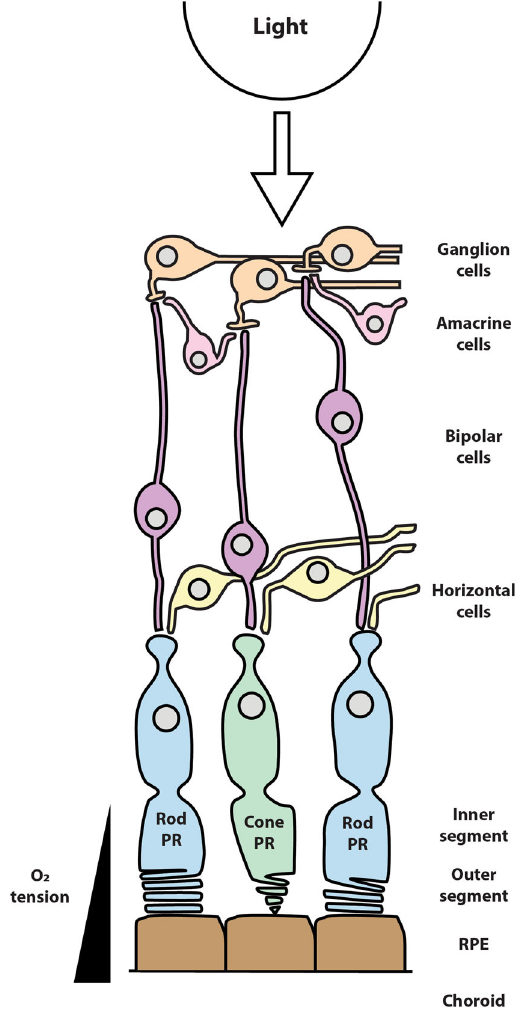
Fig. 1 The laminated retina. Schematic representation of the retina and the direction of light. Photoreceptors are the outer most layer of the neural retina and include an inner segment, which contains the majority of the mitochondria, and an outer segment, where phototransduction occurs via rhodopsin and cone opsins. Outer segments are shed with integration into nearby RPE. Oxygen tension from the choroid rapidly decreases to its lowest in the mitochondria-rich inner segment